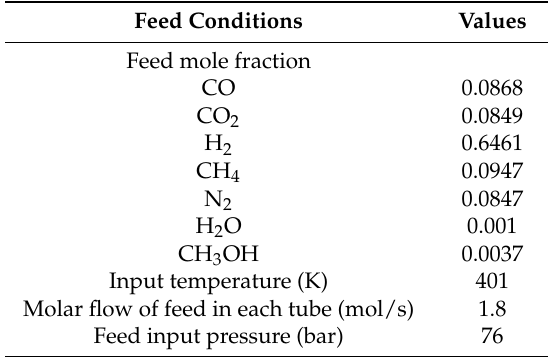
Table 3. Industrial plant input data of conventional methanol synthesis process with two reactor (CR configuration) [9].